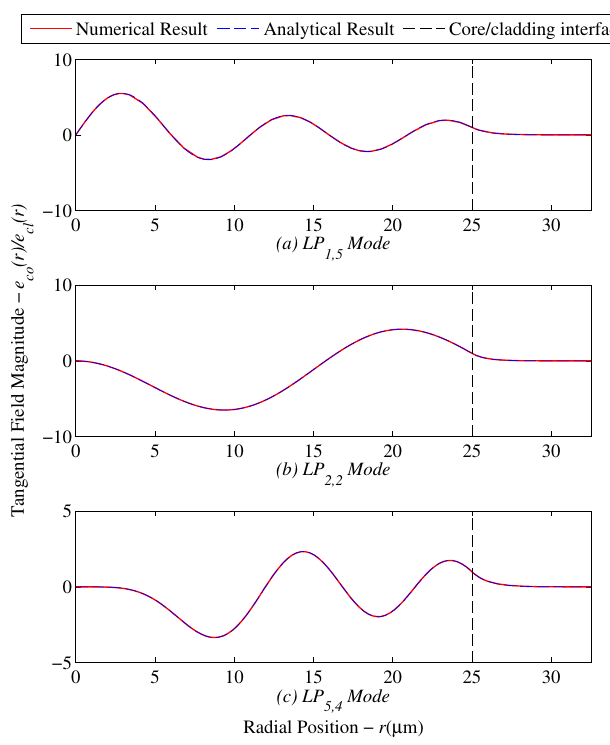
Figure 3. Radial field comparison for step index fibers for selected modes ( a ) LP 11 , ( b ) LP 22 and ( c ) LP 54 .